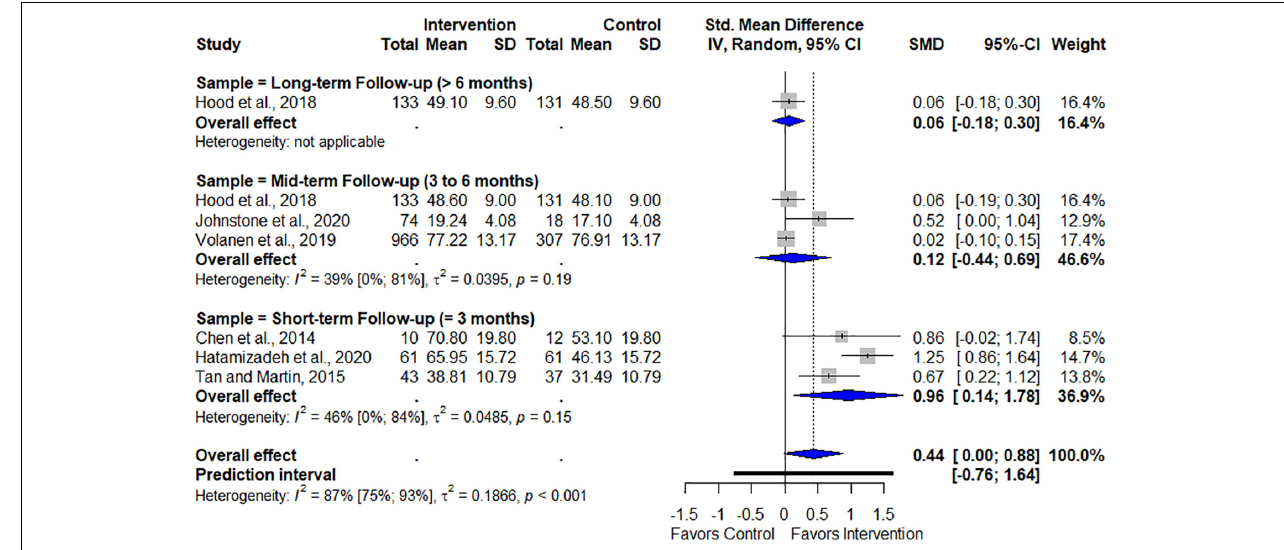
FIGURE 7 | Follow-up effects of program on